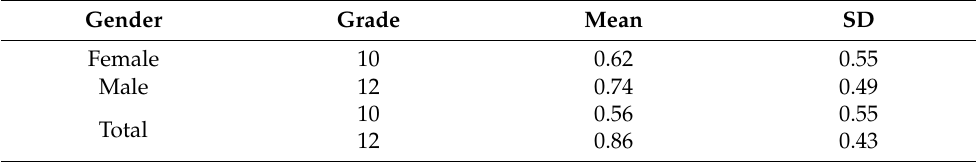
Table 7. PageRank (Popularity)